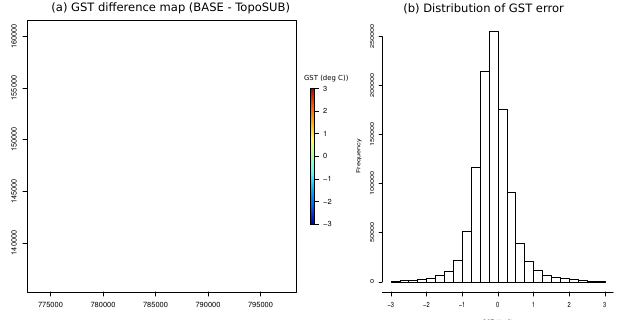
Fig. 11. (a) A visual comparison of the simulation results for GST (128 samples) presented as deviation from BASE simulation (BASE TopoSUB) and, (b) a histogram of error distribution. Errors statis- tics show the error to be reasonable: RMSE = 0.6, bias = − 0.15, standard deviation = 0.58.